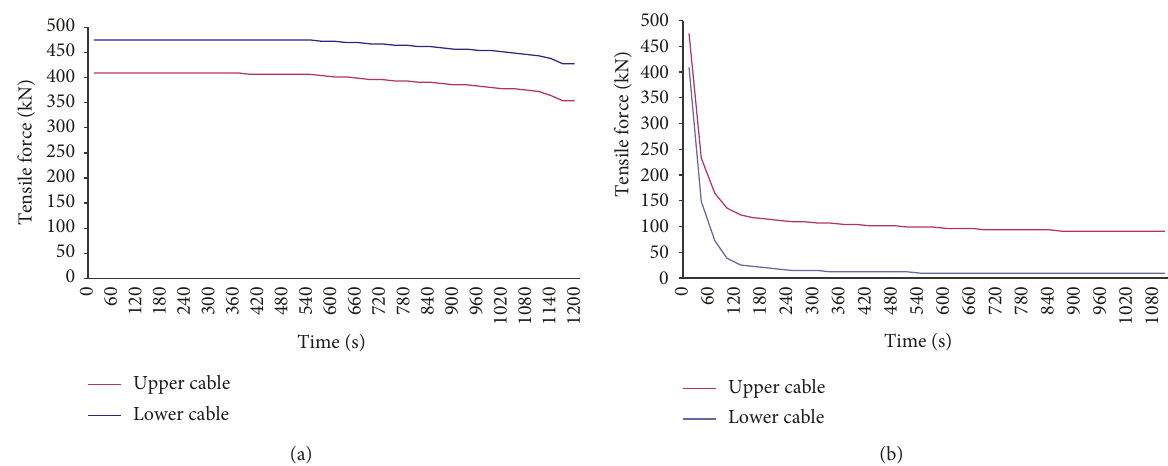
Figure 27: The tension force of central steel truss structure (a) under natural fire and (b) under standard ISO fire.